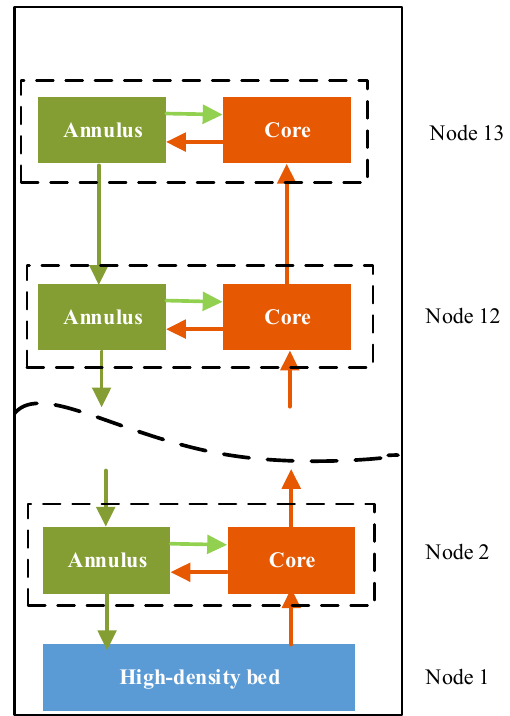
Figure 2. The calculation node in furnace.